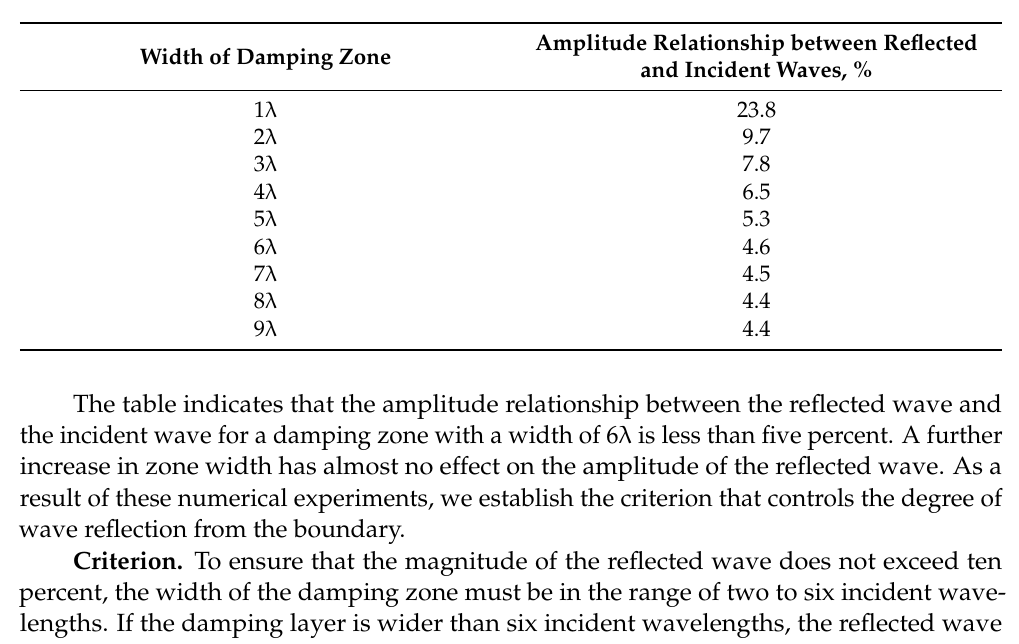
Table 2. Relationship between the amplitude of the reflected wave and the width of the damping zone.